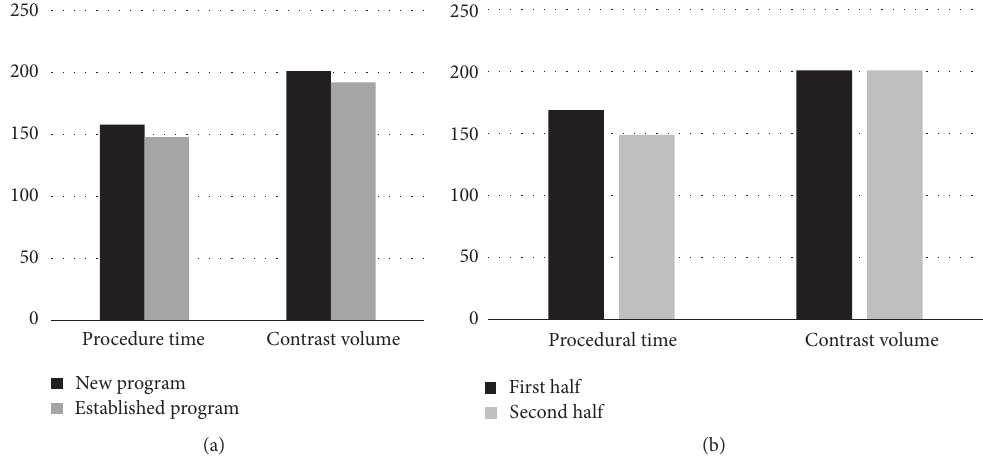
Figure 1: Procedural efficiency of new TAVR program relative to established program (a) and comparison of results of first versus second half of the first year of the new TAVR program.